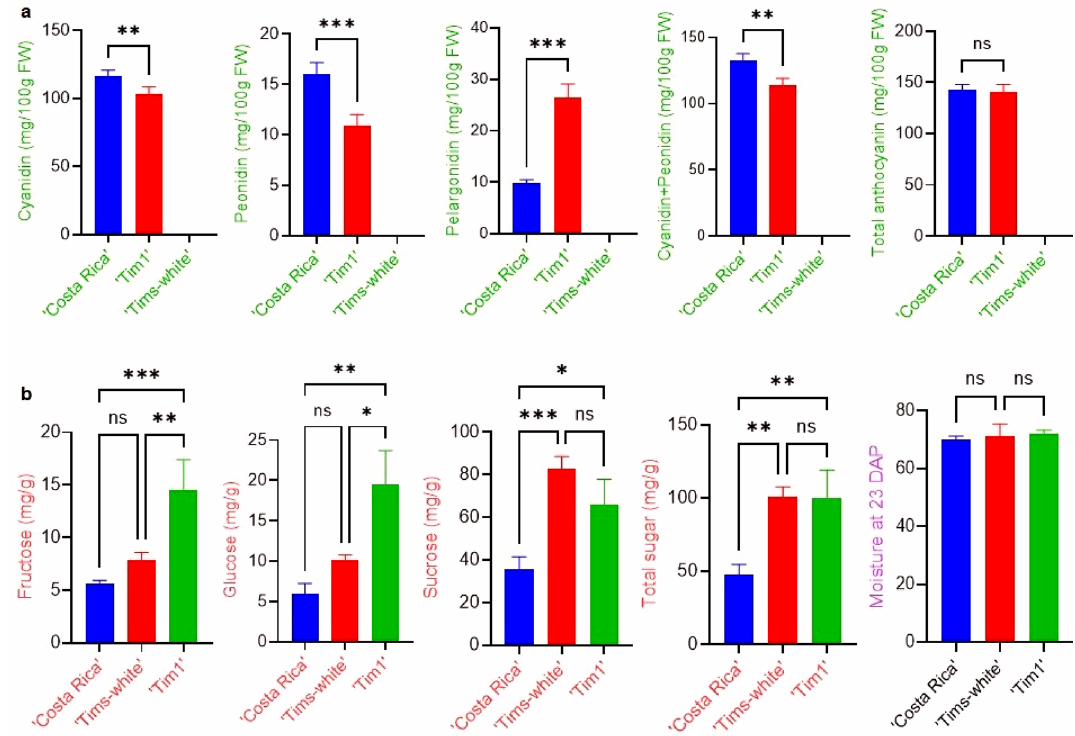
Figure 4. One-way factorial analysis of variance (ANOVA) using Fisher’s least significant difference (LSD) test for anthocyanin and sugar concentrations. Multiple comparison showing ns non-significant, *significant at P < 0.05, **significant at P < 0.01, and ***significant at P < 0.001. ( a) Anthocyanin profiles of ‘Costa Rica’ and ‘Tim1’ kernels at 23 days after pollination. The anthocyanin-base grouping (e.g. cyanidin) is indicated on the y-axis; ( b) sugar profiles of ‘Costa Rica’, ‘Tims-white’ and ‘Tim1’ kernels at 23